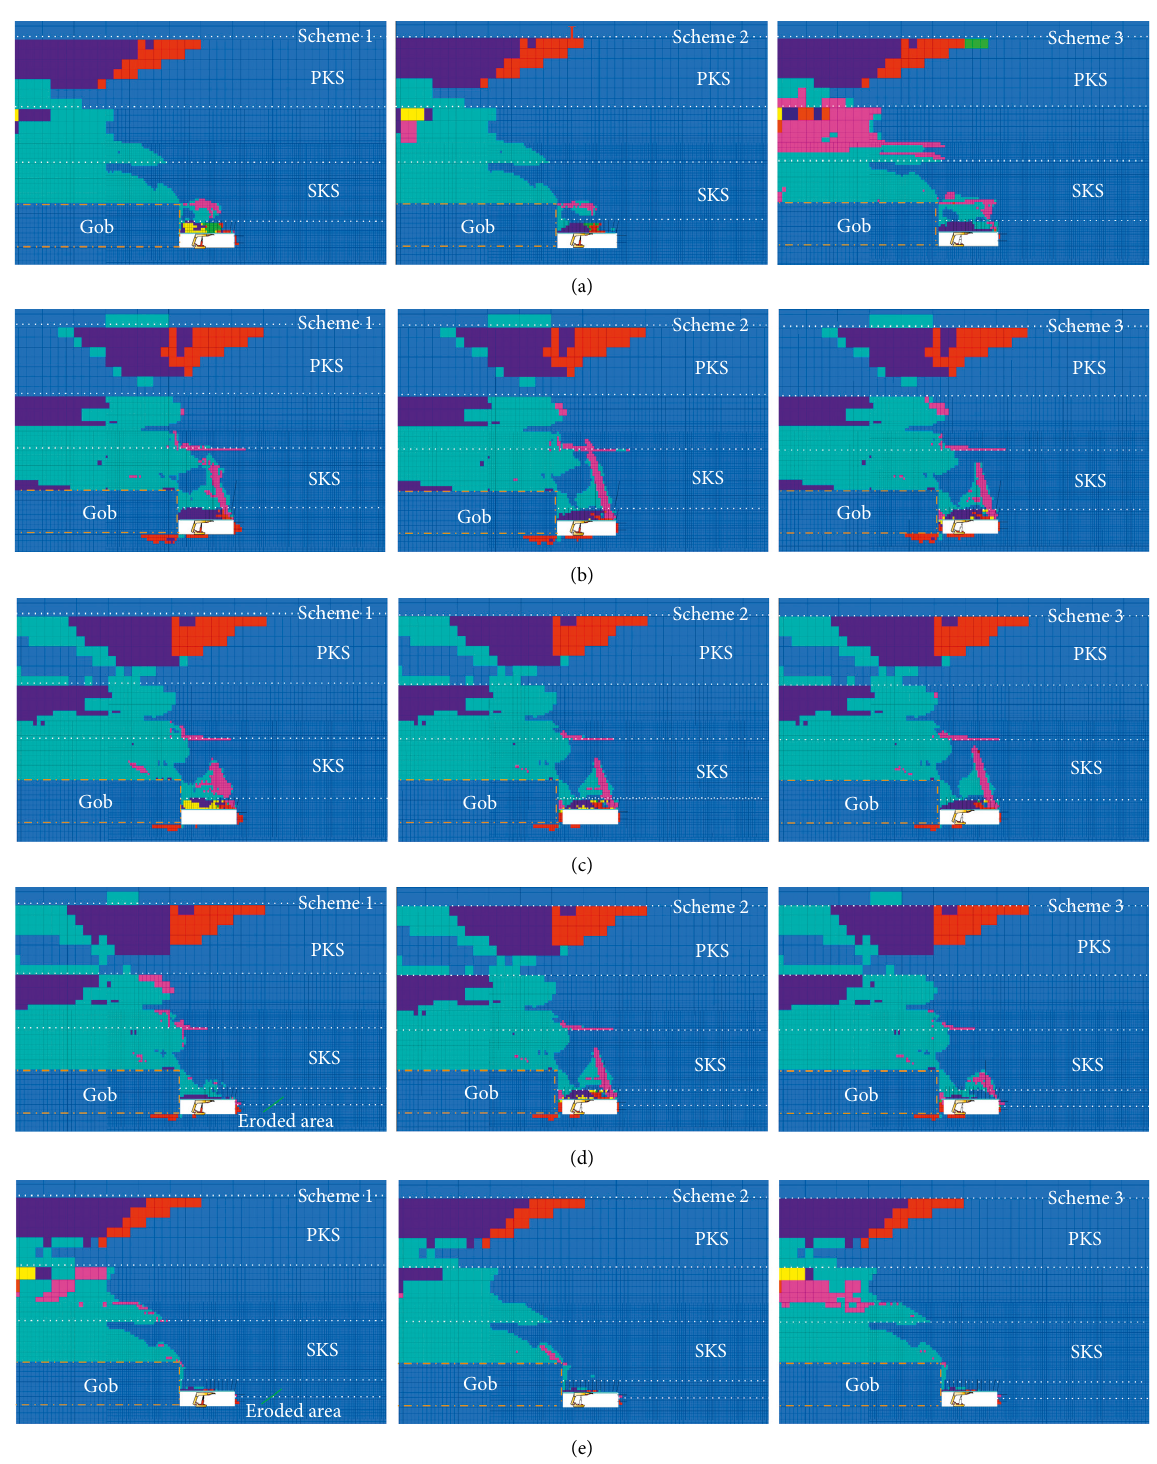
Figure 18: Plastic zone distribution of Stage I. (a) I-I. (b) II-II. (c) III-III. (d) IV-IV. (e)